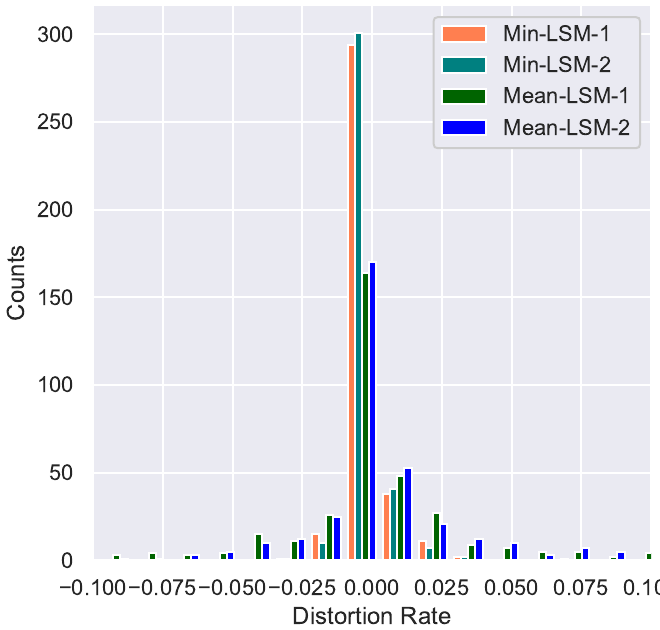
Figure 18. ResNet-18 classification feature distortion